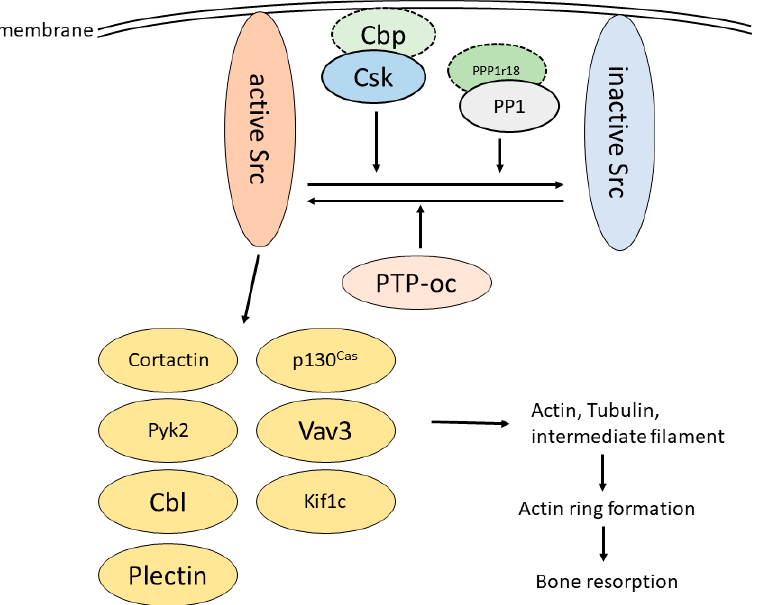
Figure 2. Schema of Src regulation and function in osteoclasts. Src is activated by osteoclast PTP-oc, which de-phosphorylates Src Y527. Src is inactivated through the phosphorylation of Src Y527 induced by the Csk/Cbp complex or the dephosphorylation of Src S16 by the PPP1r18/protein phosphatase 1 (PP1) complex. The expression of these Src-inactivating proteins is low in osteoclasts. Activated Src phosphorylates and activates downstream proteins, such as cortactin [46–48], p130Cas [49,50], Pyk2 [51,52], Cbl [53], Vav3 [54], Kif1c [55], and plectin [56,57]. These proteins organize the cytoskele- ton to form actin rings in osteoclasts. The circled by solid lines are proteins expressed in osteoclasts. The circled by dotted lines represent those that are less expressed in